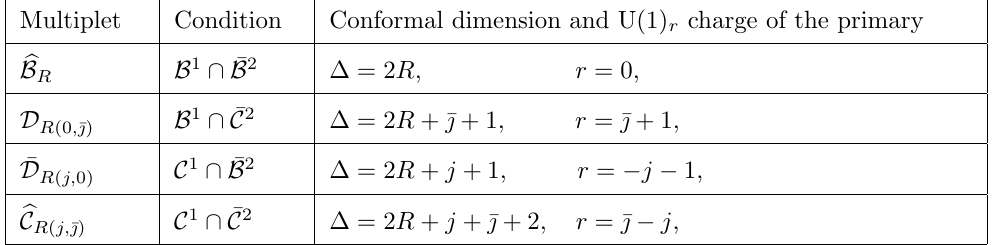
Table 1 . The list of Schur multiplets. Their shortening conditions are shown in the middle